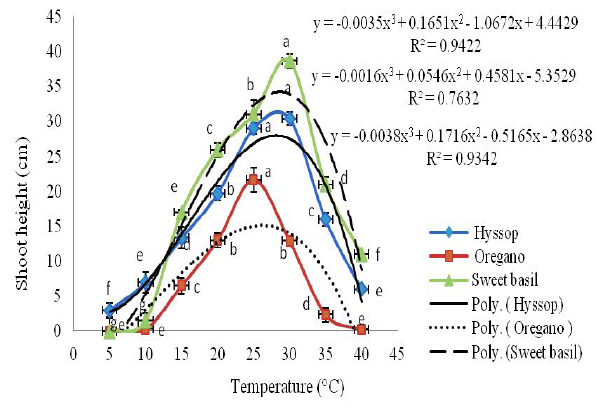
Fig. 2. Effect of temperature on seedlings growth of hyssop ( ▲ ), sweet basil and oregano (■). Fitting the third-order polynomial regression with R2 of 0.94, 0.76 and 0.93 for hyssop, oregano and sweet basil, respectively. Error bars represent one standard error of